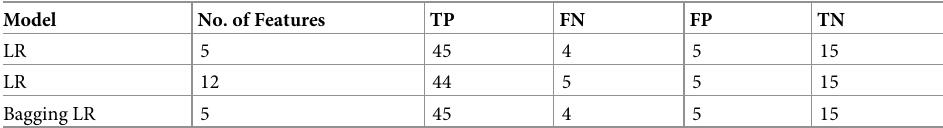
Table 12. Elements of confusion matrix for LR and bagging LR.